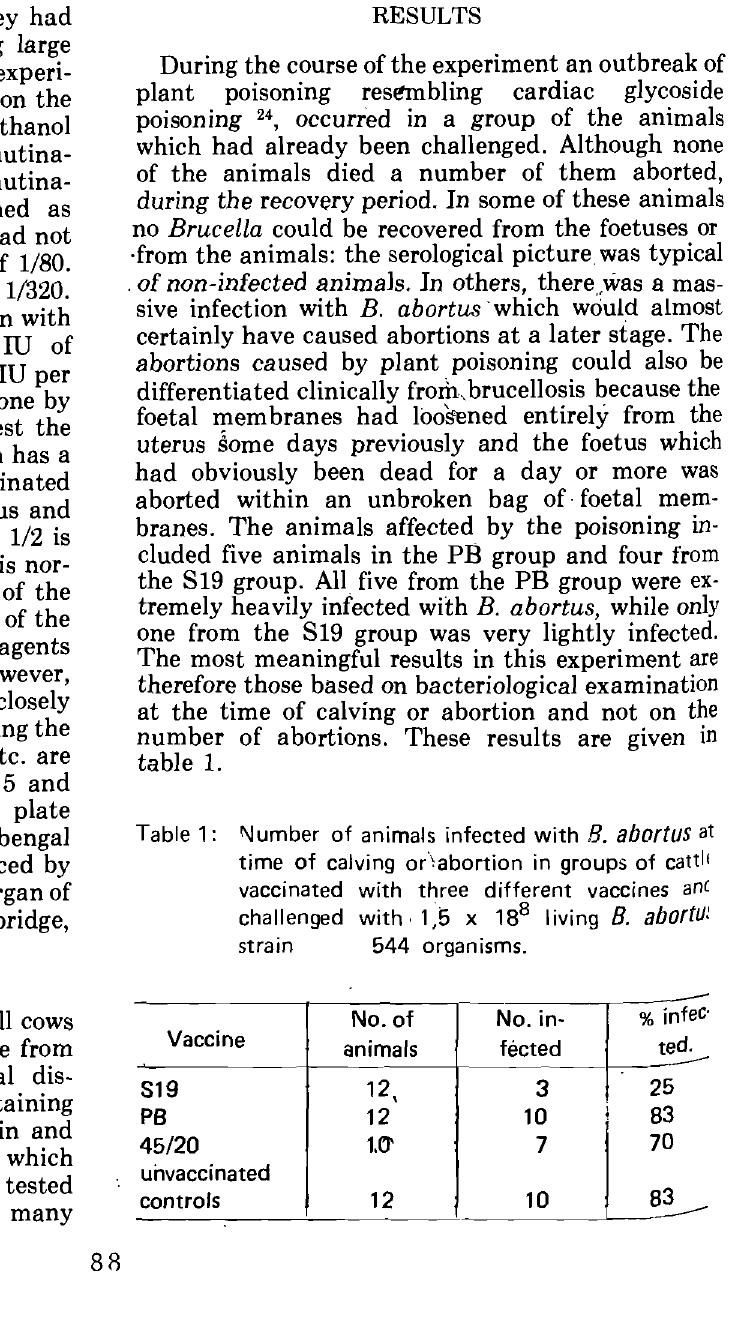
Table 1: I\lumber of animals infected with B. abortus at time of calving or\abortion in groups of cattll vaccinated with three different vaccines ant challenged with, 1,5 x 18 8 living 8. abortu~